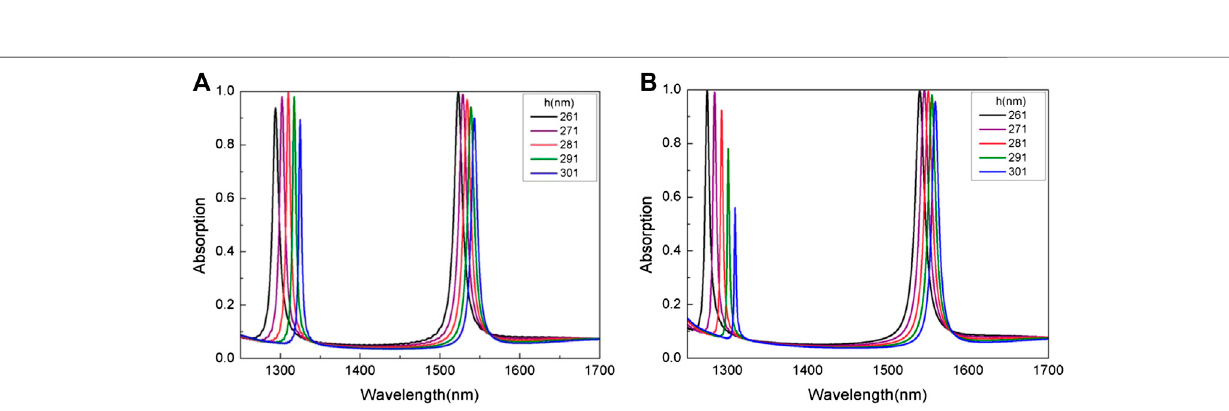
Frontiers in Physics |